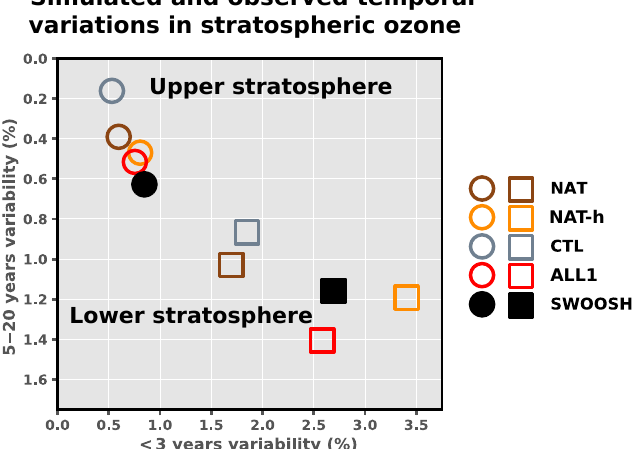
Figure 3. Comparison of simulated and observed temporal variability in global ozone anomalies in the upper and lower stratosphere. Results for the lower (upper) stratosphere are represented by square markers (circles). Variability on monthly to interannual timescales is plotted vs. variability on timescales of 5–20 years. After removal of long-term trends from raw anomalies with a 30-year low-pass filter, a Butterworth filter was used to perform band-pass and high-pass filtering. There is no overlap between the frequencies isolated by the high- and band-pass filters. Results for NAT, CTL, and NAT-h are from 1000, 200, and 168 years, respectively, while ALL1 and SWOOSH are from January 1984 to December 2014 and December 2016, respectively. Temporal SDs for the band-pass- and high-pass-filtered data are given as the percent differences from the base years of 1960–1969 in